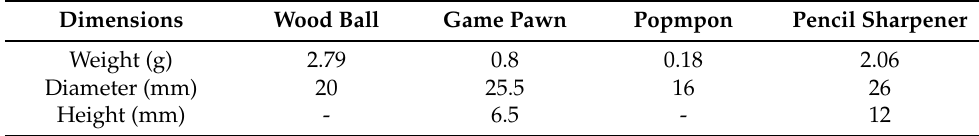
Table 6. Characteristic of gripped objects.